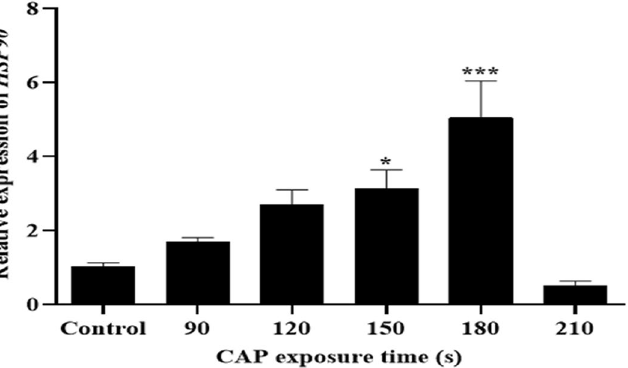
Figure 6. The expression levels of heat shock protein 90. RT-qPCR analysis of RNA levels in HSP90 gene in T. rubrum expose to CAP in different times of 90, 120, 150, 180, 210 s and control sample. Error bars represent standard deviation. Asterisks show statistically significant difference with a control (ANOVA, * P < 0.05, *** P <